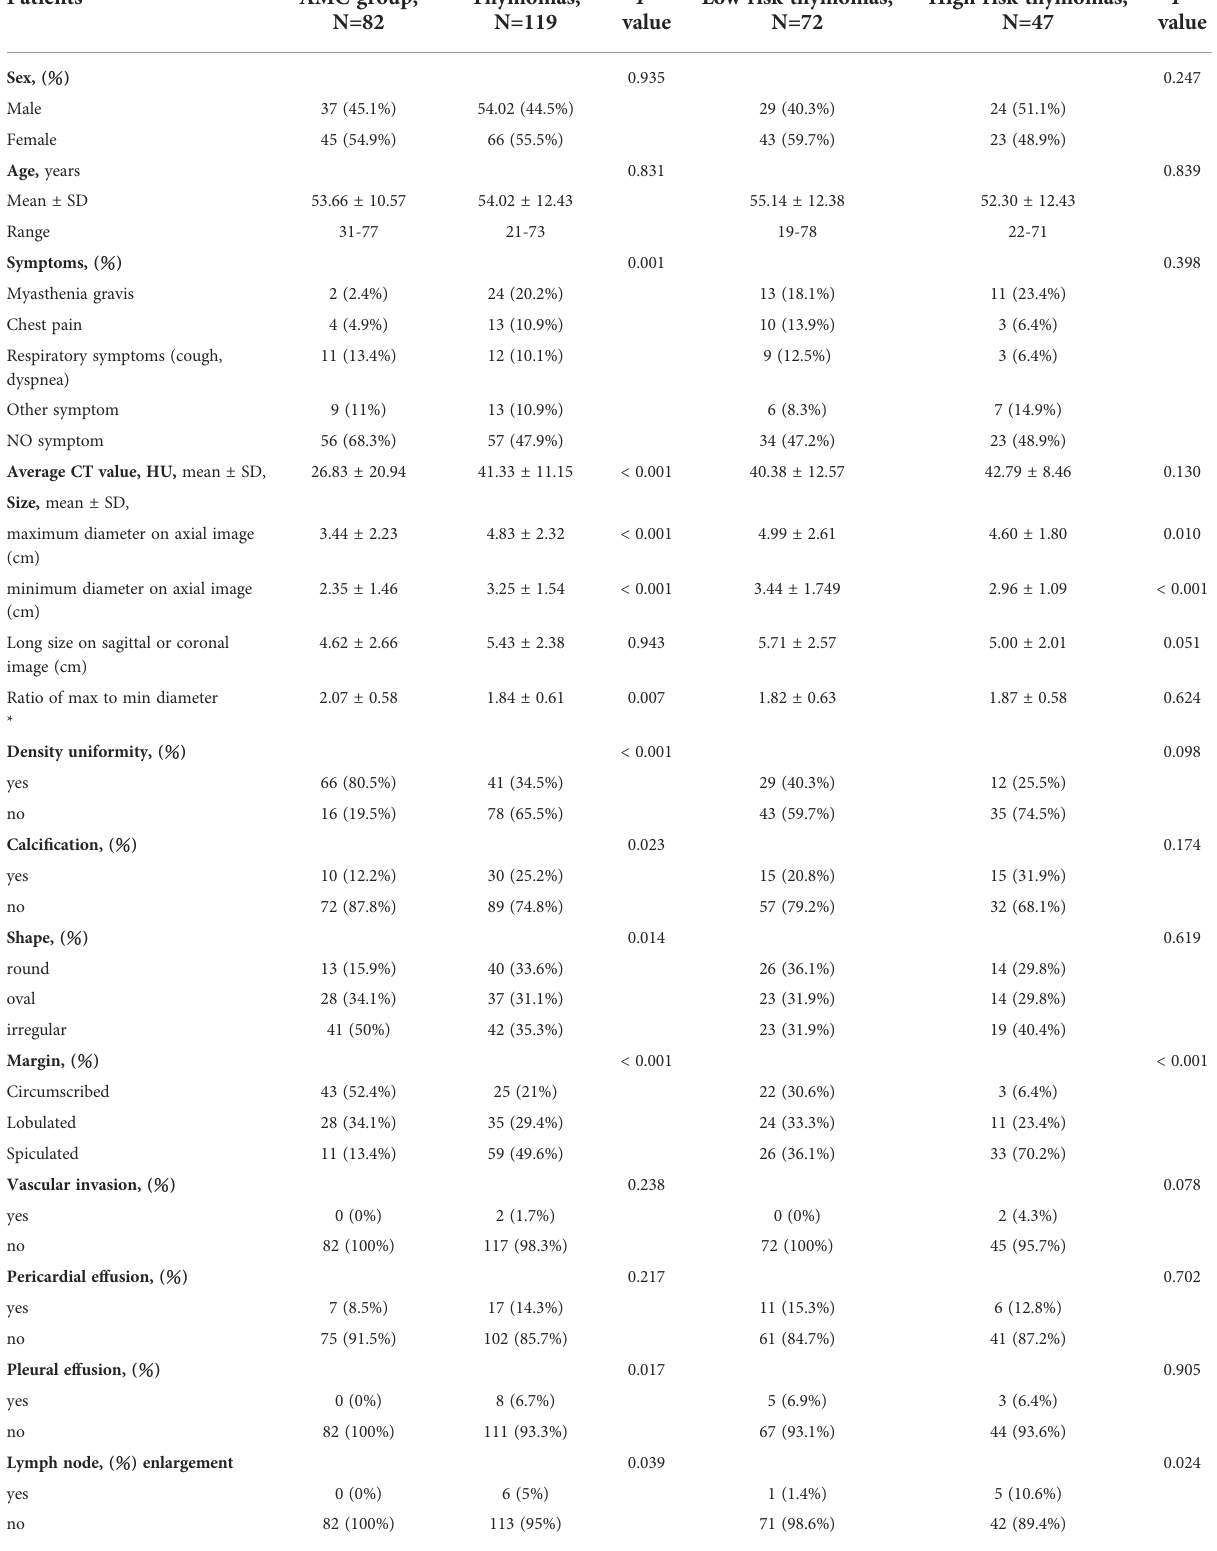
TABLE 1 Clinical characteristics of the patients and features of the